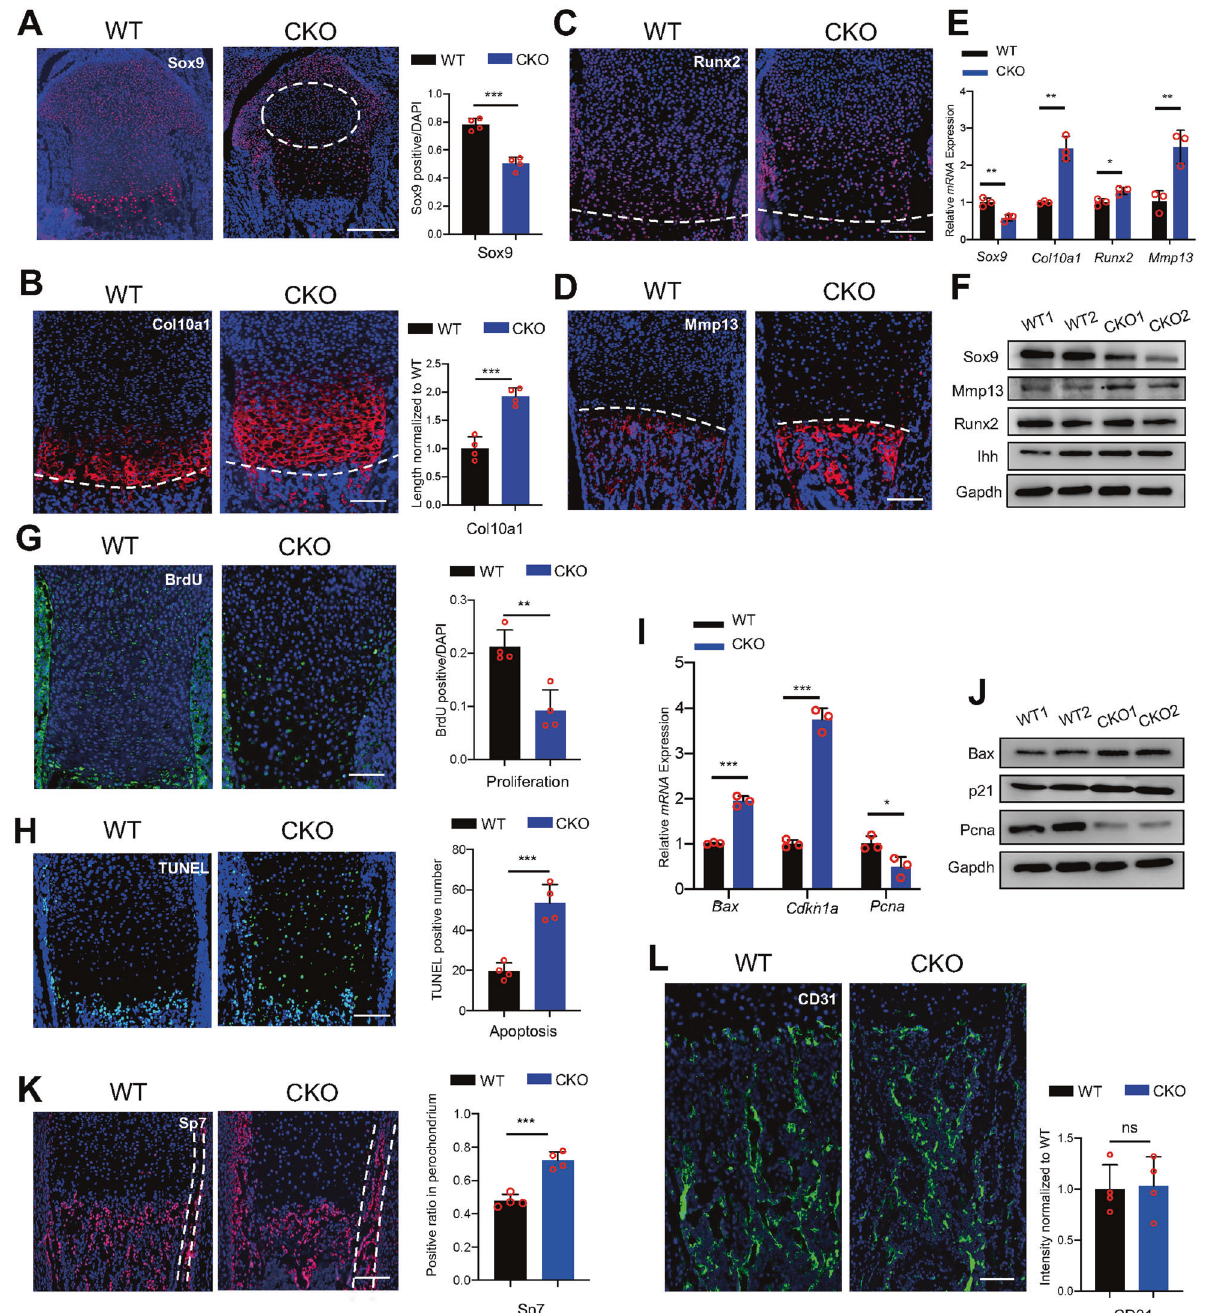
Fig. 2 Loss of Hnrnpk results in damaged survival and premature differentiation of growth plate chondrocytes. A Immunostaining of Sox9 of tibia of E18.5 WT and CKO embryos (left panel) and the quanti fi cation of Sox9 positive cells (right panel). Dotted circle: region contained atypical chondrocytes. n = 4 biological replicates. Scale bar: 100 μ m. B Immunostaining of Col10a1 of tibia of E18.5 WT and CKO embryos (left panel) and measurement of Col10a1 positive range (right panel). Dotted lines: boundary between hypertrophic zone and POC. n = 4 biological replicates. Scale bar: 100 μ m. C , D Immunostaining of Runx2 ( C ) and Mmp13 ( D ) of tibia of E18.5 WT and CKO embryos. Dotted lines: boundary between hypertrophic zone and POC. Scale bar: 100 μ m. E mRNA expression level of Sox9 , Col10a1 , Mmp13 , and Runx2 of E18.5 WT and CKO growth plate cartilage. n = 3 biological replicates. F Protein level of Sox9, Mmp13, Runx2, and Ihh of E18.5 WT and CKO growth plate cartilage. G , H BrdU assay ( G ) and TUNEL assay ( H ) of tibia of E18.5 WT and CKO embryos (left panel) and the quanti fi cation of BrdU and TUNEL positive cells (right panel). n = 4 biological replicates. Scale bar: 100 μ m. I mRNA expression level of Bax , Cdkn1a , and Pcna of E18.5 WT and CKO growth plate cartilage. n = 3 biological replicates. J Protein level of Bax, p21, and Pcna of E18.5 WT and CKO growth plate cartilage. K , L Immunostaining of Sp7 ( K ) and CD31 ( L ) in POC of tibia from E18.5 WT and CKO embryos (left panel) and the quanti fi cation of Sp7 and CD31 staining (right panel). Dotted lines: perichondrium. n = 4 biological replicates. Scale bar: 100 μ m. p -value was calculated by two-tailed unpaired Student ’ s t -test. Data were shown as mean ± SD. * p < 0.05; ** p < 0.01; *** p < 0.001; ns: not signi fi cant.